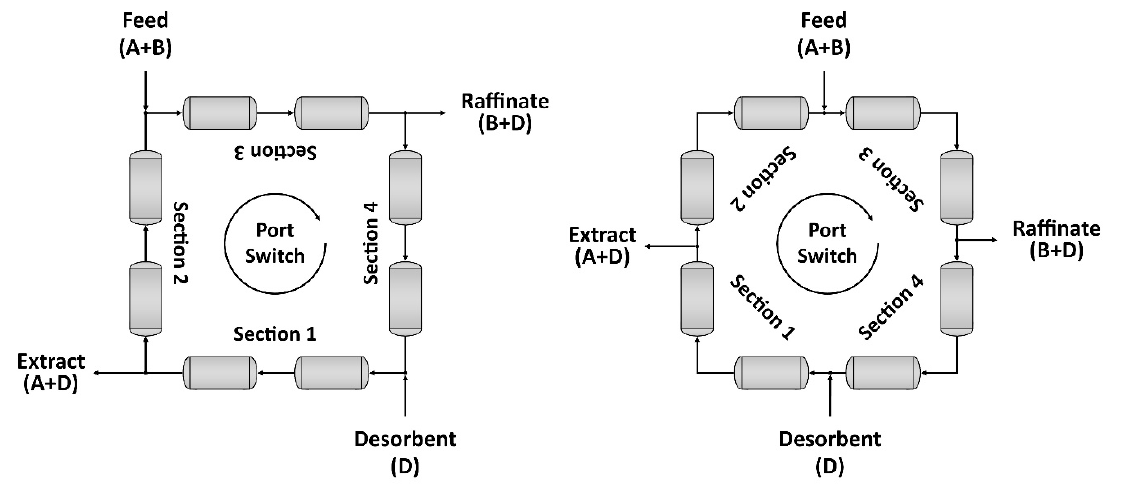
Figure 3. Simulated moving bed process.